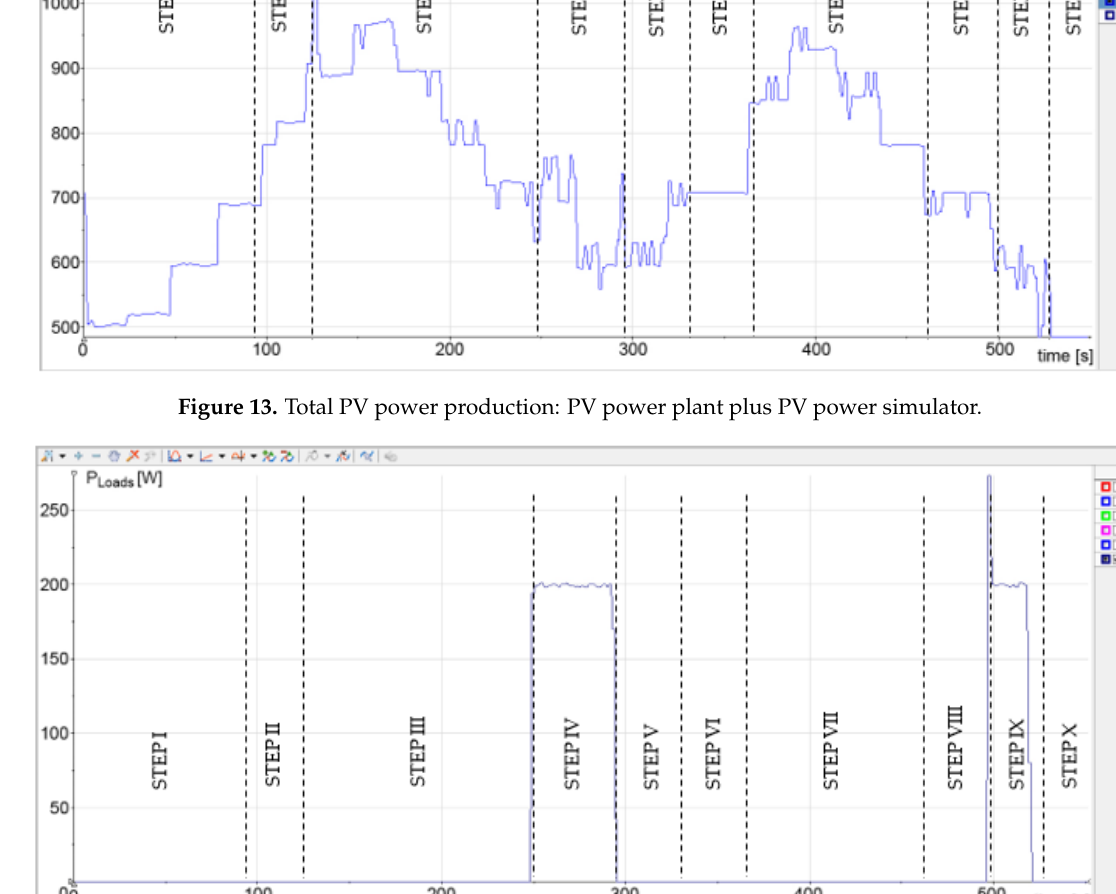
Figure 14. Power request from demonstration panel to supply non-critical loads.